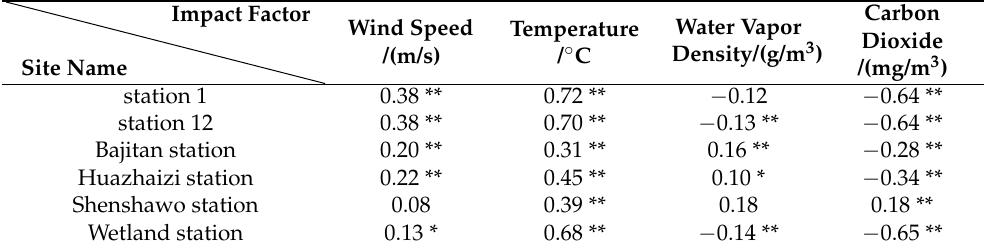
Table 3. The correlation coefficients of LE and influencing factors under different underlying surface types.